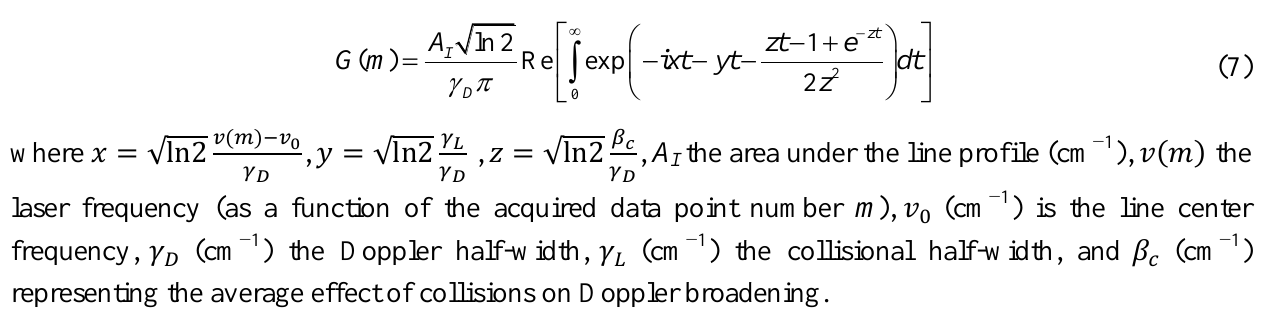
Figure 4. Discrete Fourier transform of the fit residuals resulting from different spectral fitting